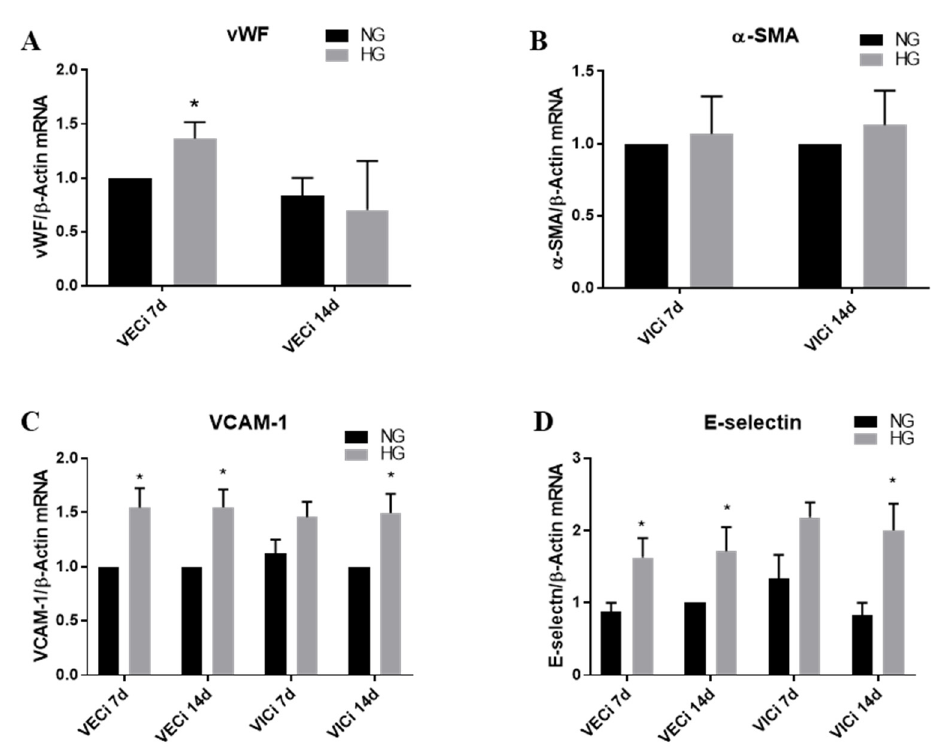
Figure 4. ( A , B ) Gene expression of von Willebrand Factor (vWF) and alpha smooth muscle actin ( α -SMA) in VEC and VIC, respectively. ( C , D ) Gene expression of VACM-1 and E-selectin in VEC and VIC. Cells were isolated from 3D constructs after 7 and 14 days of exposure to NG (5 mM glucose) or HG (25 mM glucose) conditions. The results are presented as fold change versus NG condition for every type of cell and investigated time. N = 3, * p < 0.5.